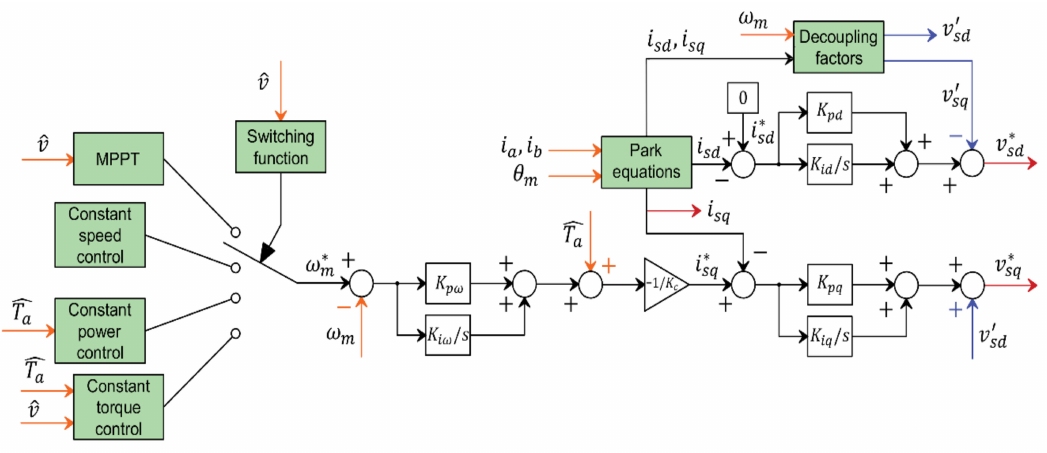
Figure 4. Variable structure controller.